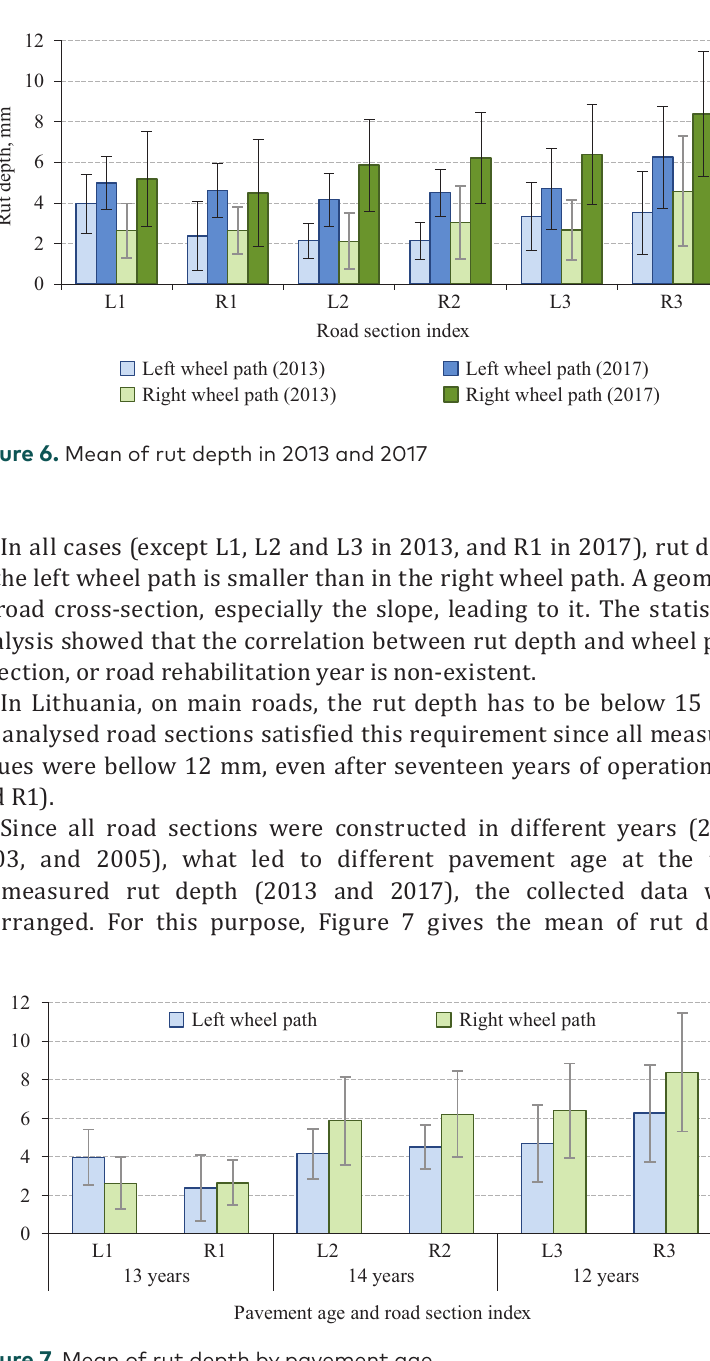
Figure 7. Mean of rut depth by pavement